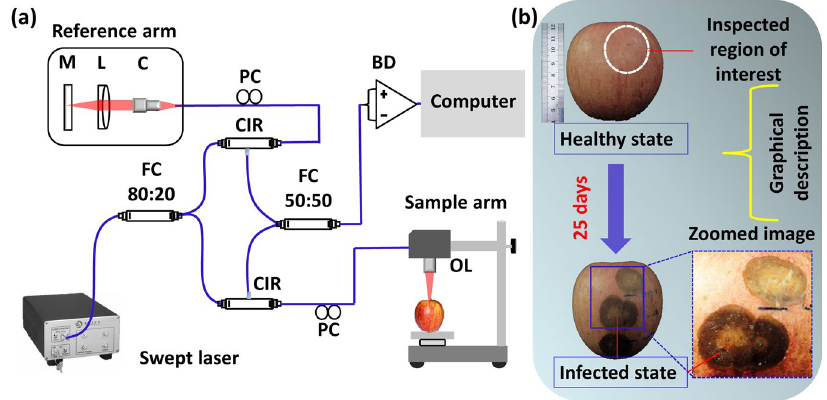
Figure 1. ( a ) Schematic diagram of the SS-OCT system configuration. ( b ) Graphical representation of the inspected fruit specimen. Abbreviations: BD, balanced detector; C, collimator; CIR, circulator; FC, fiber coupler; L, lens; M, mirror; OL, objective lens; PC, polarization